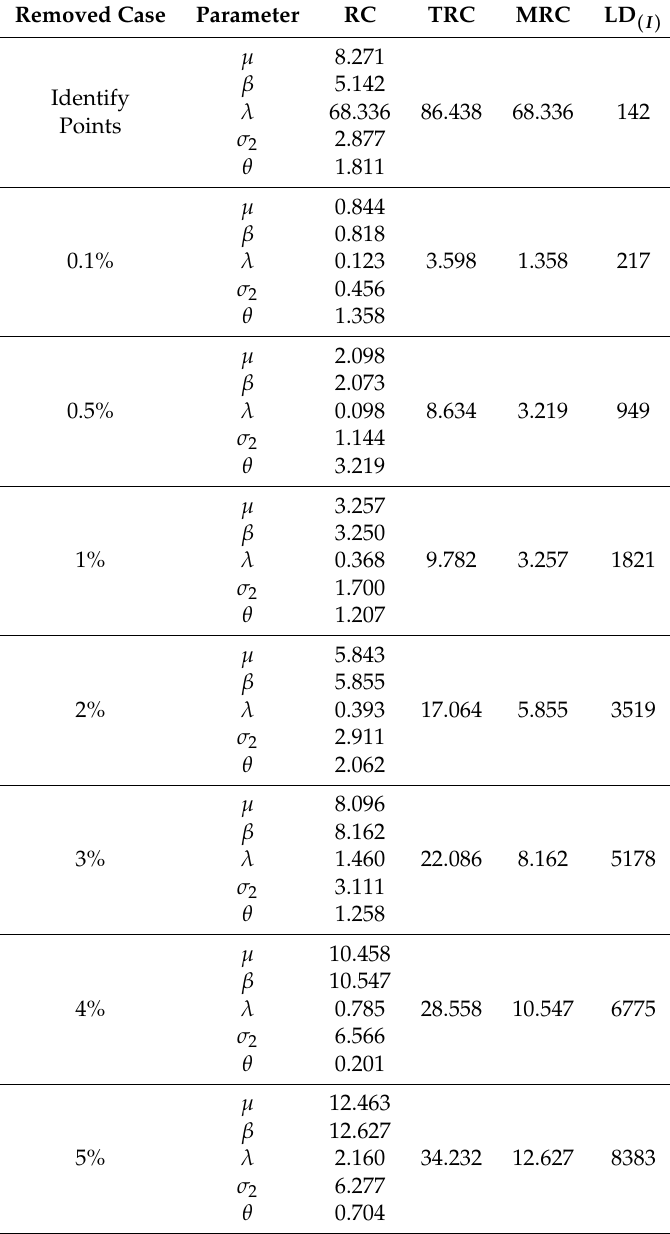
Table 4. RC (in %) and the corresponding TRC, MRC and LD ( I )